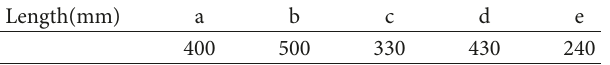
Figure 1: Programmer of the impact experiment. Table 1: Size of the shipboard